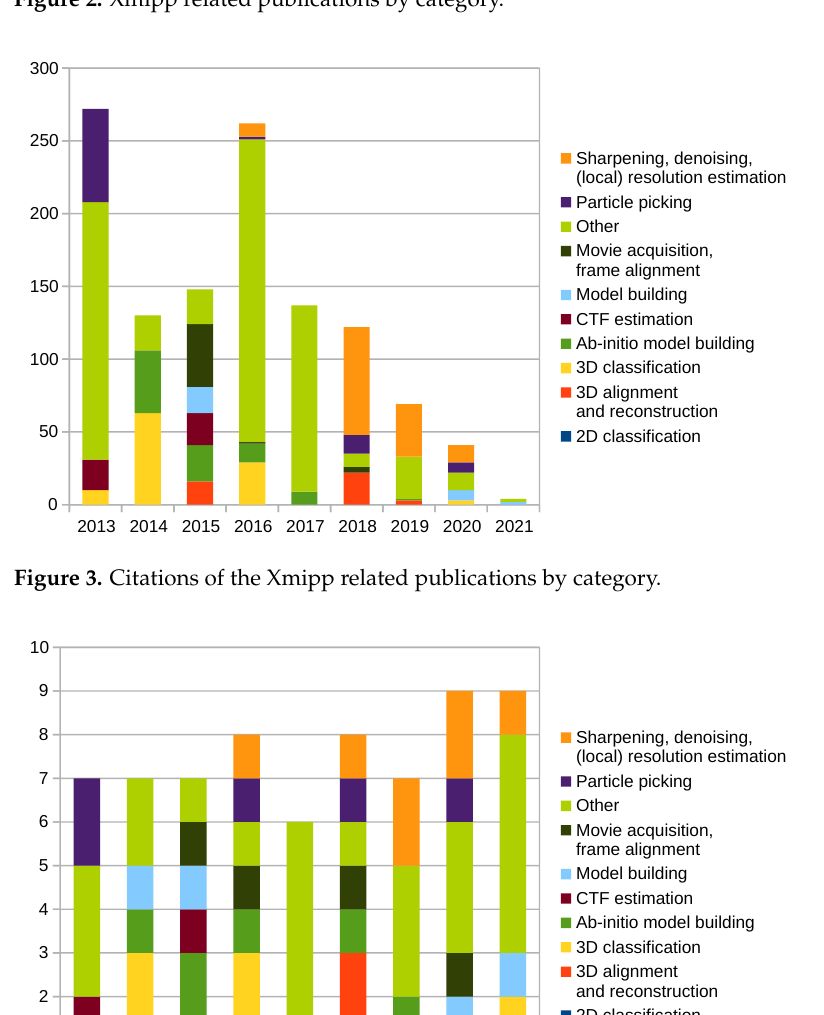
Figure 2. Xmipp related publications by category.